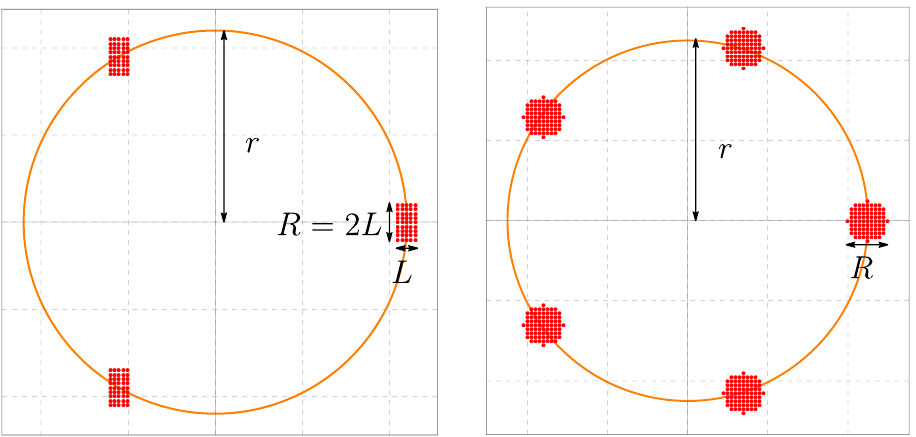
Figure 9 . We show two examples of the N -gon arrangements of entangling regions considered in the lattice. The one in the left figure corresponds to N = 3 for rectangles with dimensions L × 2 L . The one in the right figure corresponds to N = 5 for disk regions. In each case, r is defined as the radius of the circumference which shares center with the N -gon and passes through the center of the entangling